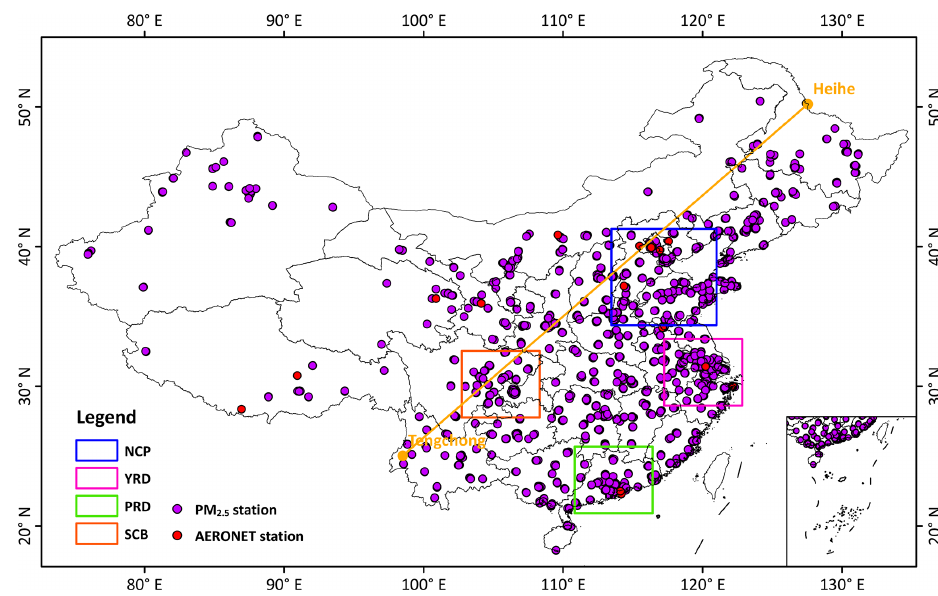
Figure 1. Spatial distributions of PM 2 . 5 and AERONET monitoring stations in China. The Heihe–Tengchong line (orange line) shows the boundary between eastern and western China.